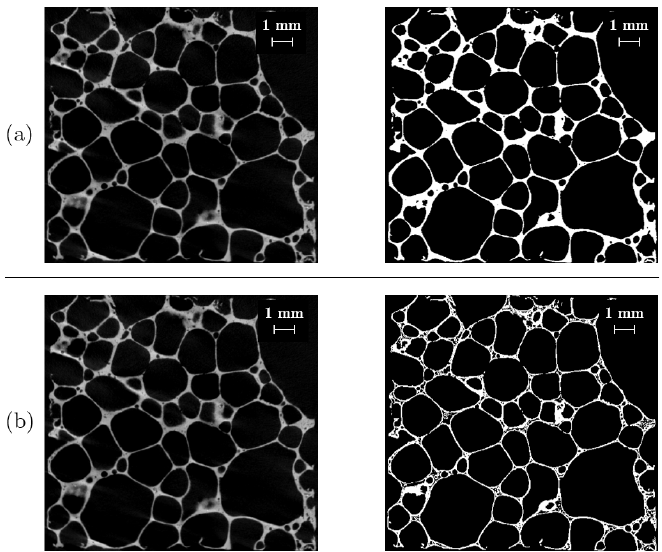
Figure 2. ( a )Application of the Otsu thresholding technique in 3D, which yields a threshold k of 70, and ( b ) application of the Mean-C technique (Radius of 2 and constant of 5) to the closed-cell foam